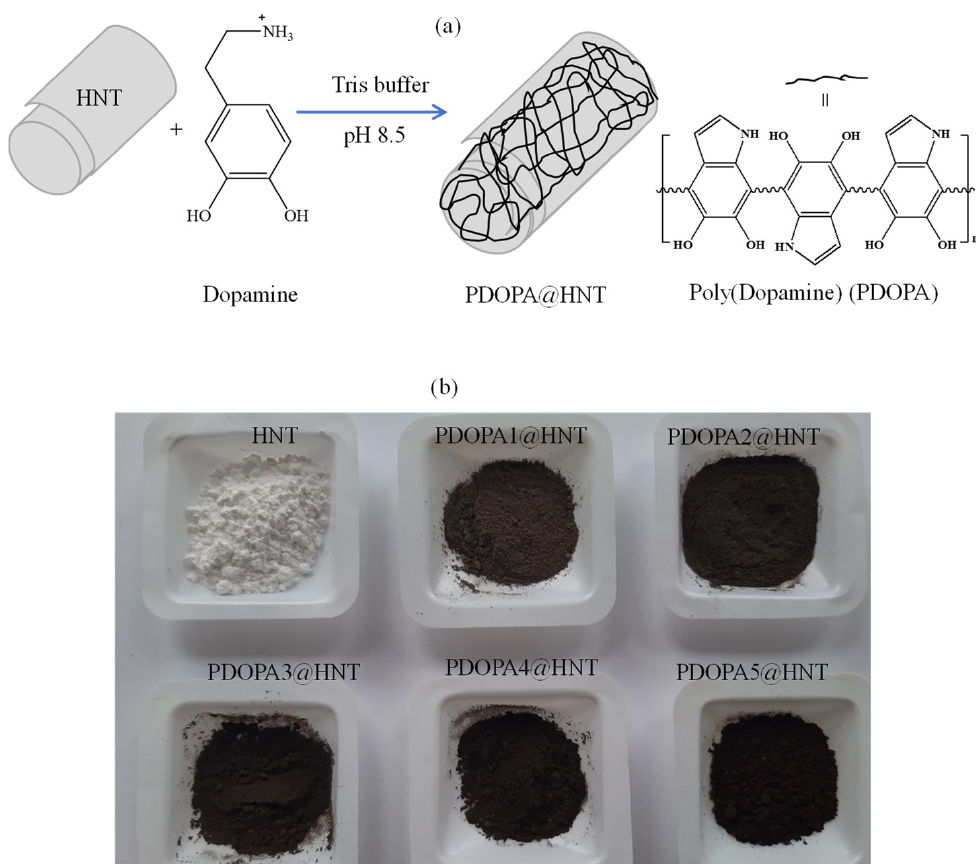
Figure 1. ( a ) Schematic representation of PDOPA coating of HNTs, and ( b ) digital camera photographs of PDOPA@HNT.